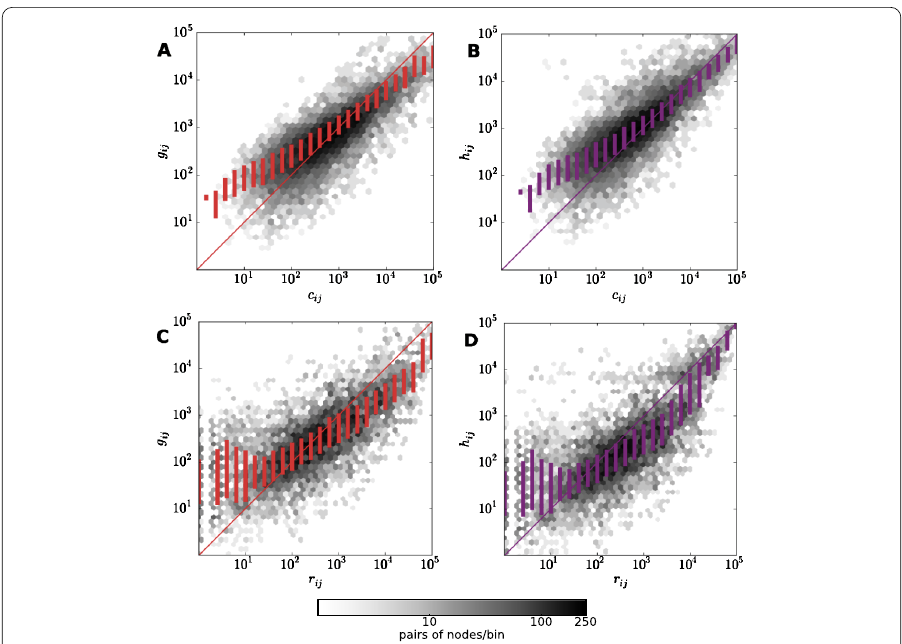
Figure 4 Mobility models predictions. These 2D-histograms compare the predicted values against the real flow values for (A) , (C) the gravity model; (B) , (D) the hybrid model. Each point represents flows with some real/estimated flow value relation. Points color in a gray scale represents the frequency values. The boxplots correspond to the interquartile range within a bin. (A), (B): US Commuting network. (C), (D): US air travel